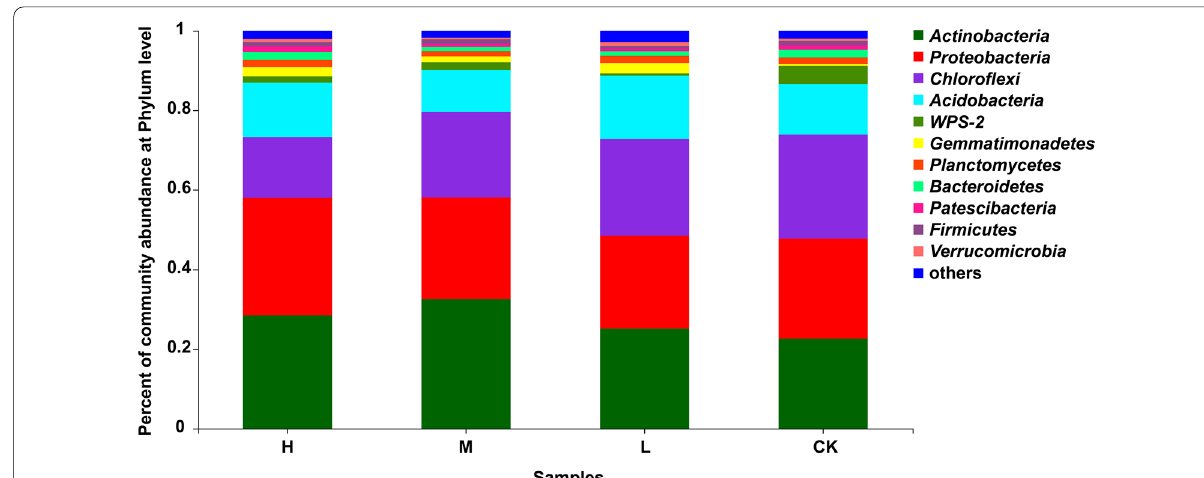
Fig. 1 Compositions of soil bacterial communities at phylum level under four N application treatments. H: high N application in the sugarcane soil (964 kg ha − 1 ), M: medium N application in the sugarcane soil (482 kg ha − 1 ), L: low N application in the sugarcane soil (96 kg ha − 1 ), CK: no N application in the sugarcane soil (0 kg ha − 1